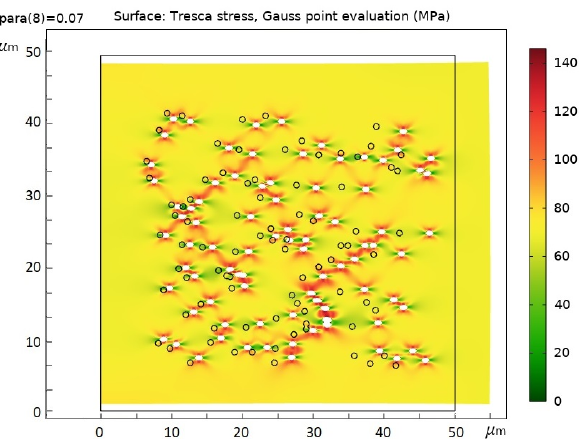
Figure 9. Simulation of the plastic–elastic deformation of TMs by the net-point method at one axis extension. The direction of the extension is horizontal. Dark-red zones correspond to zones with maximum stress concentrations; green represents zones of unloading.